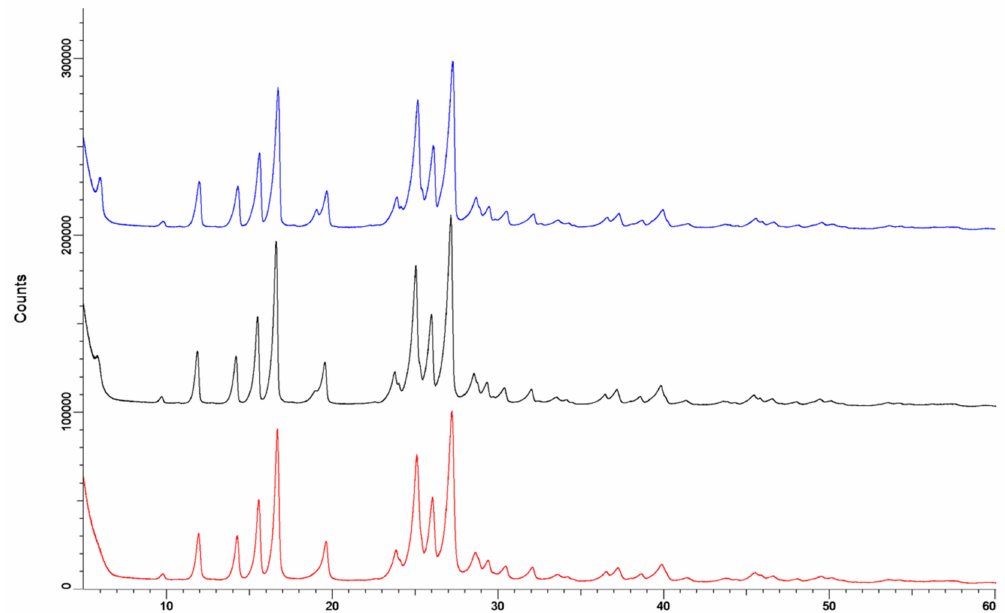
Figure 10. The X-ray spectra of the isoniazid + 5% l -leucine samples. The red line is directly after spray drying, the black line is after storage at 0% RH for 48 h and is o ff set by 100,000 counts. The blue line is after storage at 90% RH and is o ff set by 200,000 counts.